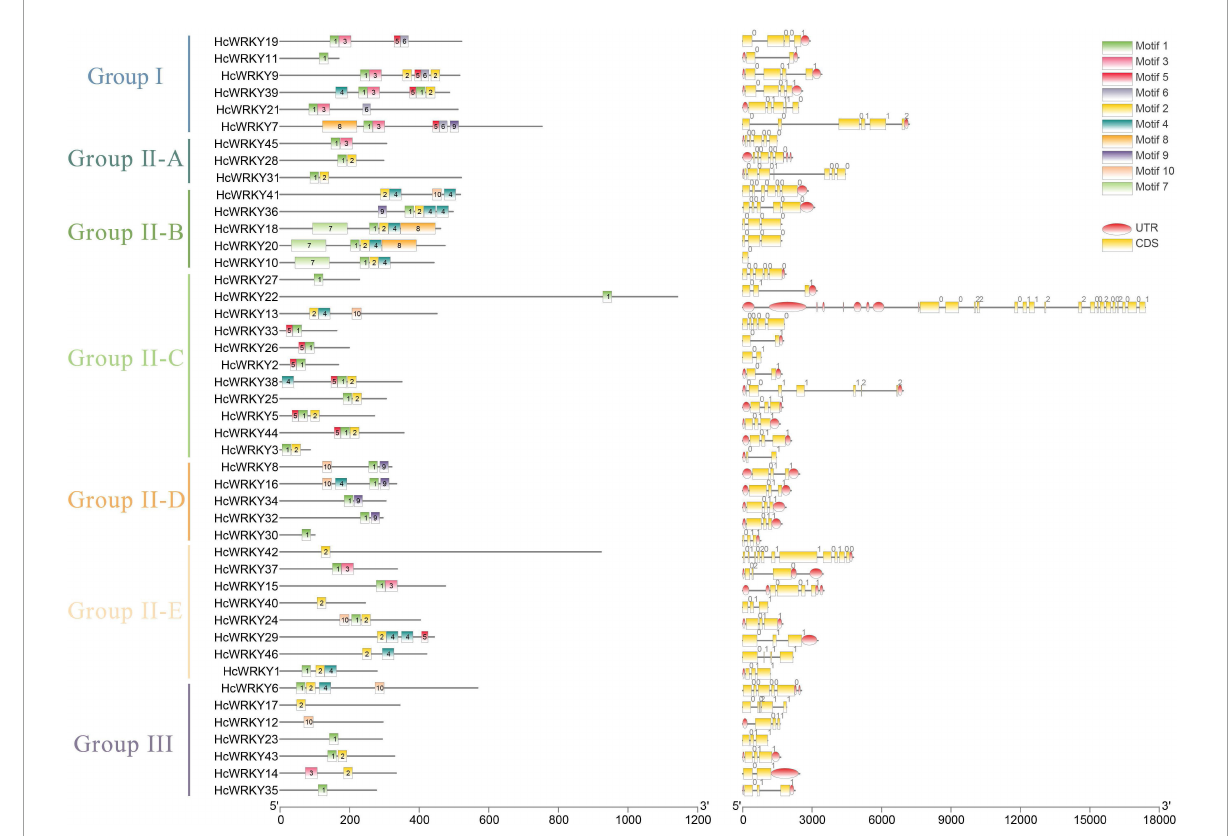
FIGURE2 Conserved motifs and gene structures of the HcWRKY proteins. The left line shows the 10 conserved motifs of WRKY proteins were identified by the MEME program in kenaf, indicated by different colors and numbers. Motif 1 and motif 2 are essential components of the WRKY domain. The right line shows the exon-intron structure organization of the corresponding HcWRKY genes performed by the online tool GSDS. The red oval represents the UTR, the yellow rectangle represents the CDS, and the gray lines represent the